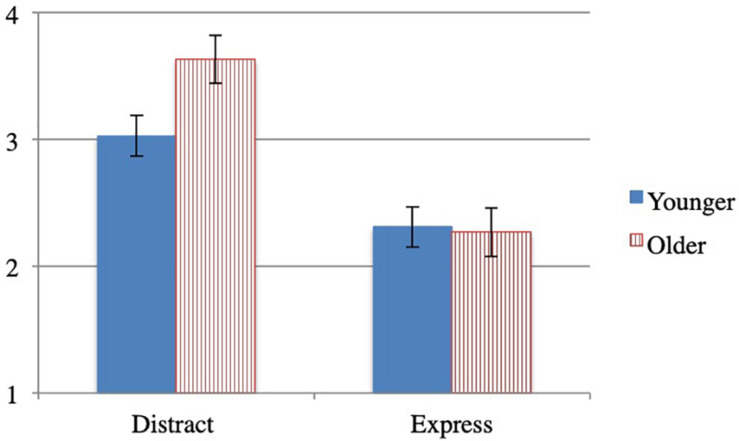
Study 1 mean absorption by condition and age group.